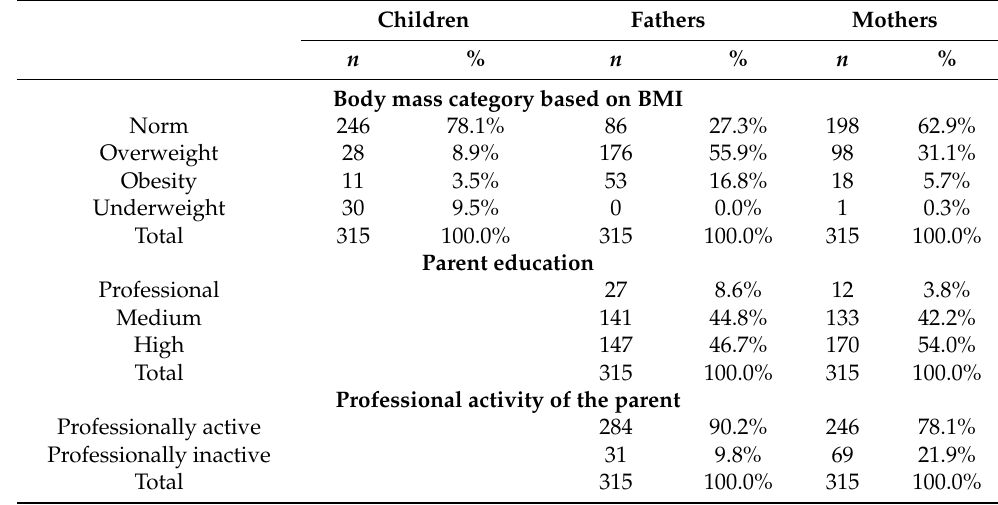
Table 2. Body mass category on the basis of BMI as well as education and professional activity of parents.